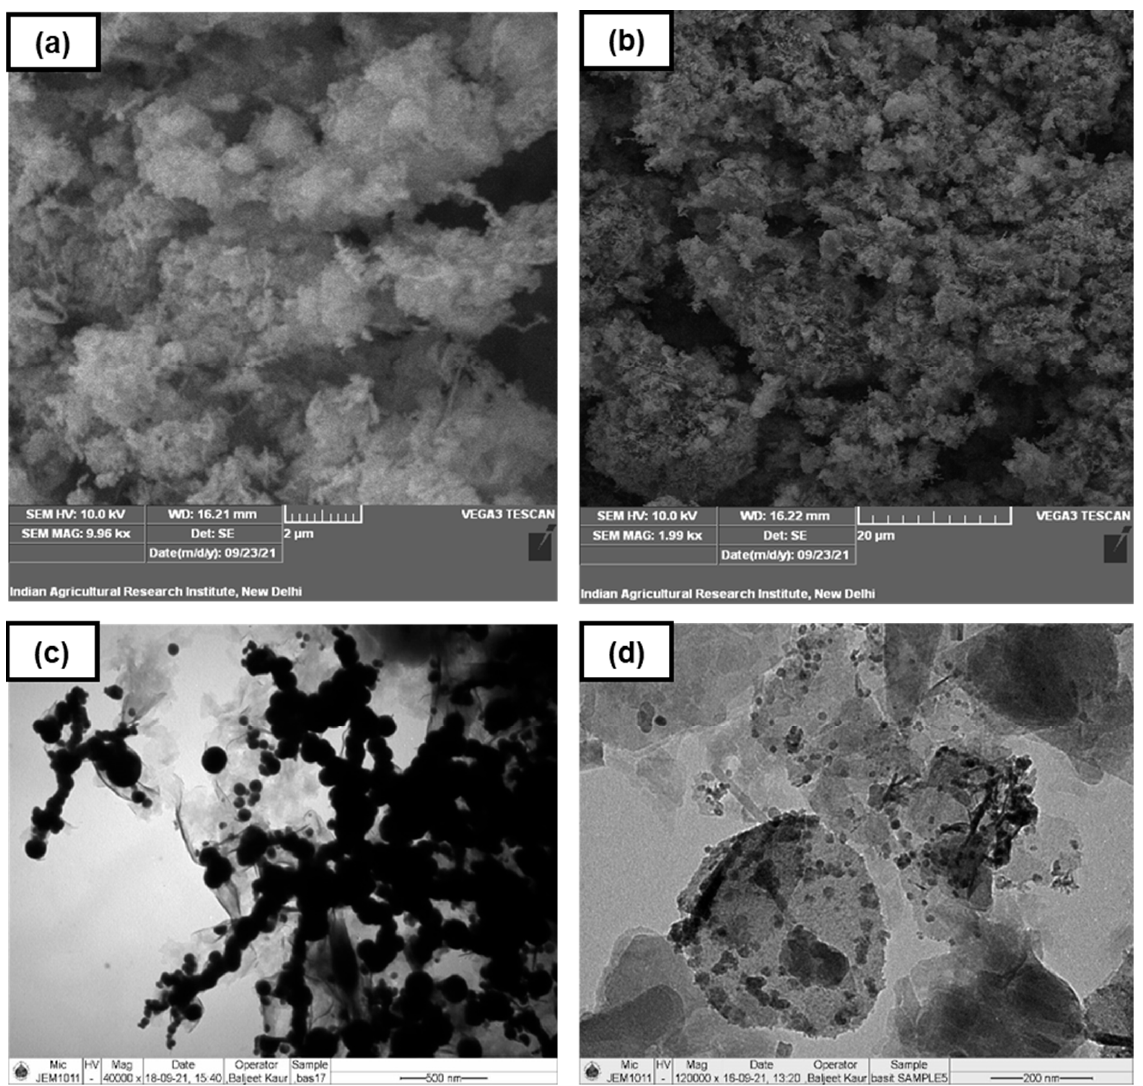
Figure 1. Images showing the characterization of ZVI products using scanning and transmission electron microscopy (SEM and TEM): ( a , b ) SEM images of nZVI-Bare and nZVI-Bento, respectively; ( c , d ) TEM images of nZVI-Bare and nZVI-Bento, respectively.